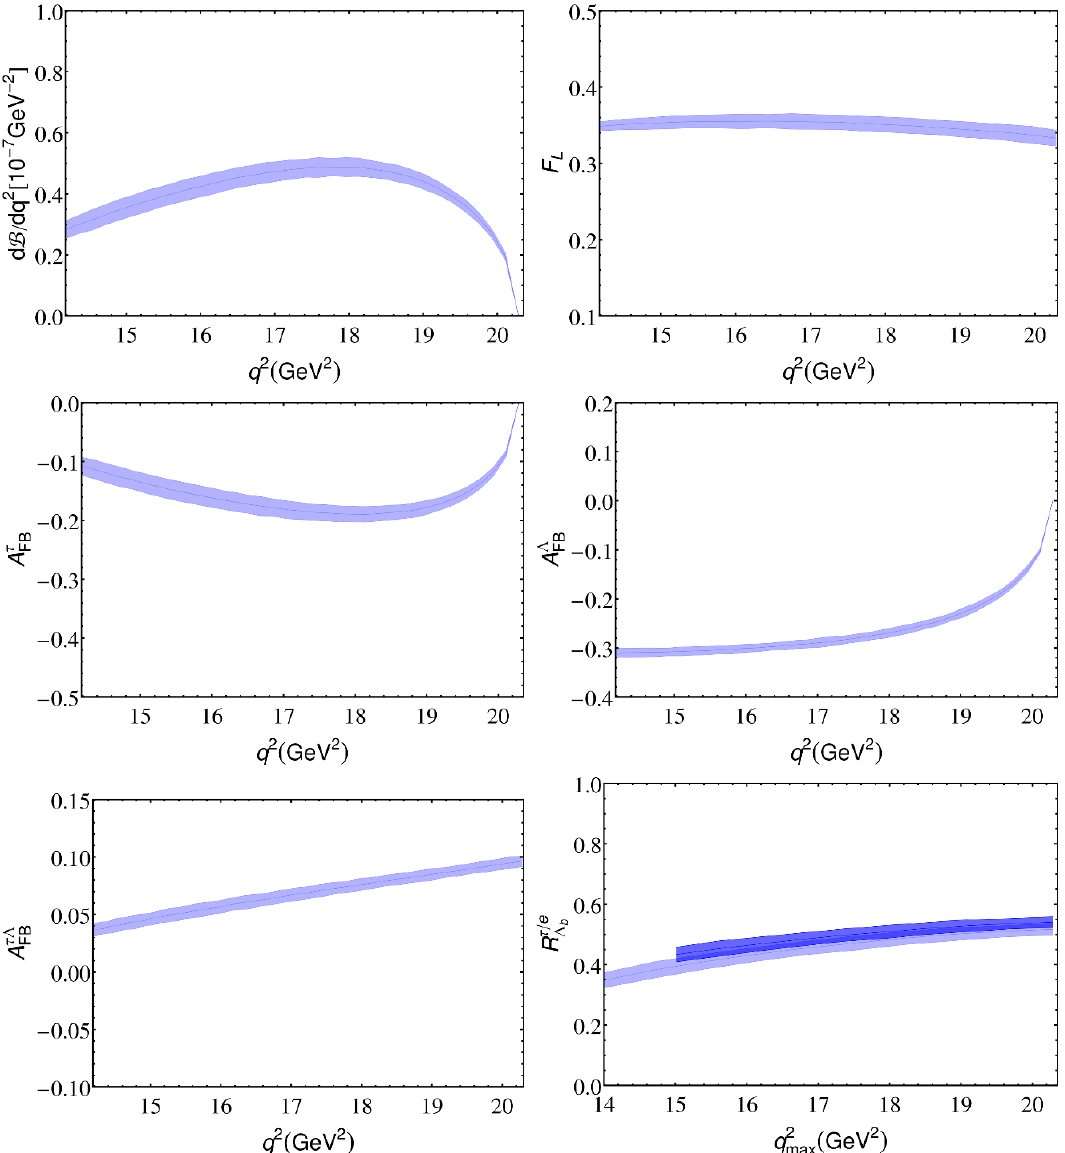
Figure 1 . The SM predictions of various (cid:3) b ! (cid:3)( ! p + (cid:25) (cid:0) ) (cid:28) + (cid:28) (cid:0) observables as a function of q 2 . The R (cid:28)=e is shown as a function of the upper limit of integration q 2 for two values of max (cid:3) lower integration limit q 2 = 14 GeV 2 (light blue) and q 2 = 15 GeV 2 (dark blue). The bands min min correspond to the uncertainties discussed in text. Since the OPE at large q 2 does not capture local resonance structures, the distributions can be locally o(cid:11) from the OPE predictions.